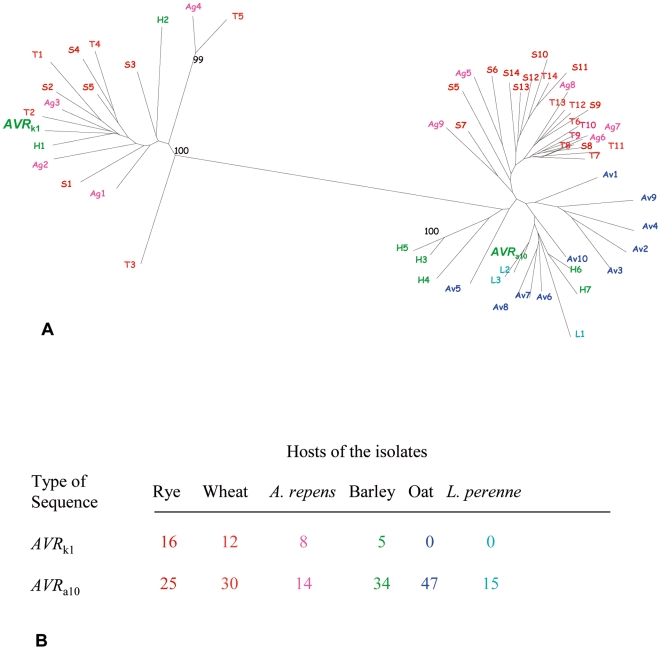
Analysis of sequences of the AVR
k1 family from formae speciales of B. graminis.A. Neighbor Joining tree of the sequences obtained by degenerate primers from isolates of B. graminis from grass hosts: rye (f. sp. secalis, S, in red), wheat (f. sp. tritici, T, in orange), Agropyron spp. (f. sp. agropyri, Ag, in magenta), barley (f. sp. hordei, H, in green), oat (f. sp. avenae, Av, in blue) and Lolium perenne (L, in cyan). The sequences of the genes AVR
k1 and AVR
a10 are in a larger font. Bootstrap support (1,000 replicates) is shown if higher than 90%. Only sequences with a maximum identity to other sequences in the family less than 90% were used in the analysis. B. Number and type of sequences homologous to AVR
k1 and AVR
a10 obtained by degenerate PCR from B. graminis from different hosts.